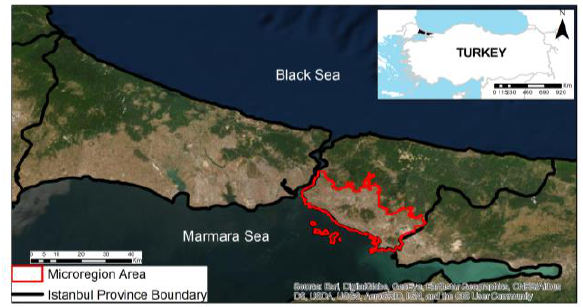
Figure 1. Microregion area located in the Istanbul